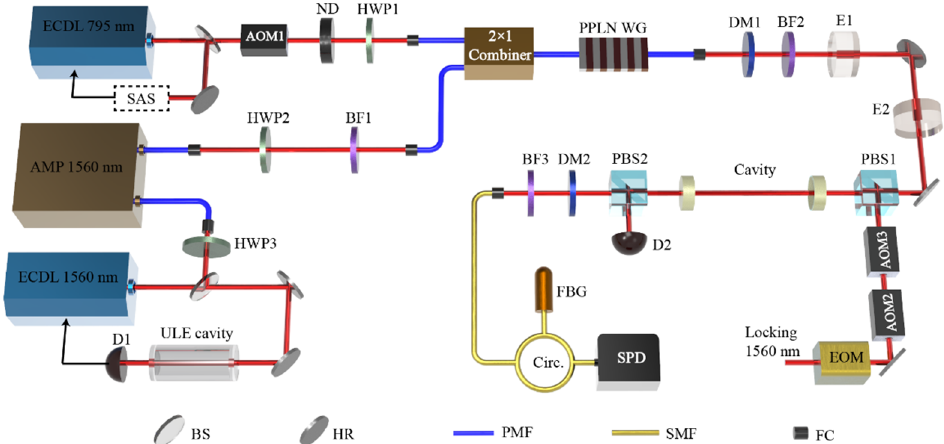
Figure 1. Experimental setup for frequency down conversion. ECDL: external cavity diode laser.